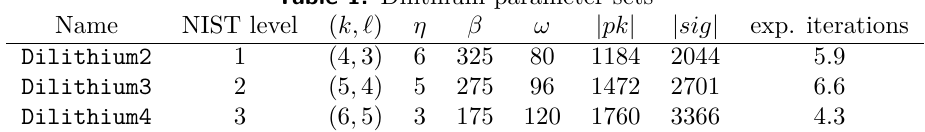
Table 1: Dilithium parameter